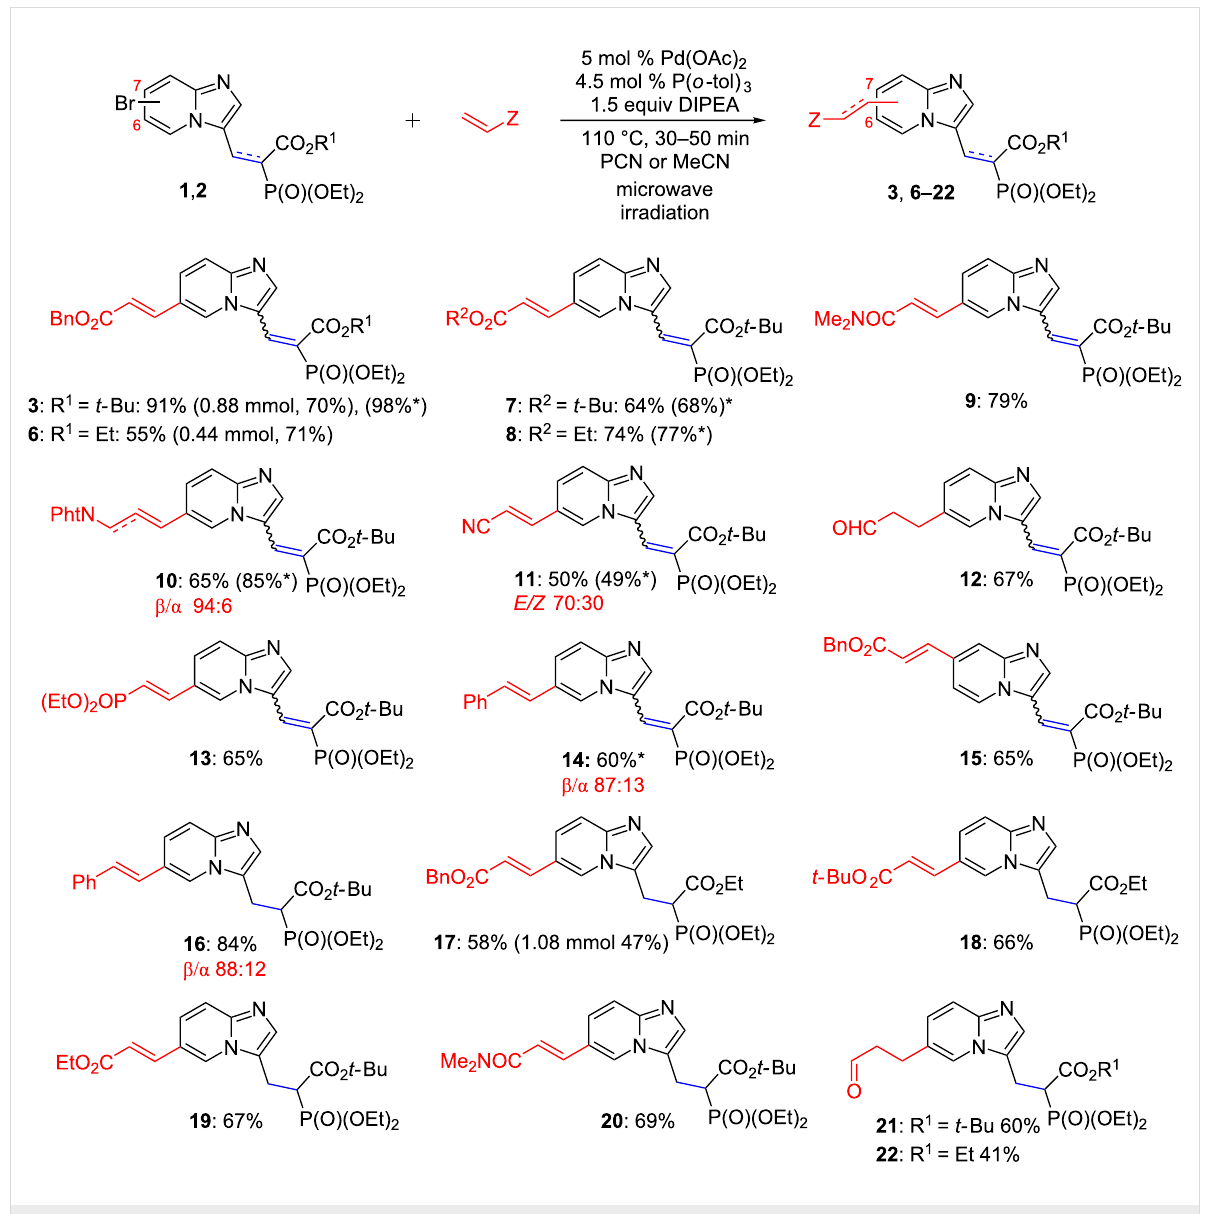
Scheme 1: Scope of the method for analogs derived from 1 and 2 . The ratio of isomers is given ( E / Z or β / α ) in red, wherever applicable. Yields are given for reactions run at a 100 mg (0.22 mmol) scale, except for compounds 3 (0.88 mmol), 6 (0.44 mmol), 18 (0.11 mmol, 40 min, 100 °C), and 17 (1.08 mmol) as indicated below the appropriate structures. Asterisks indicate yields for the reaction carried out in acetonitrile.